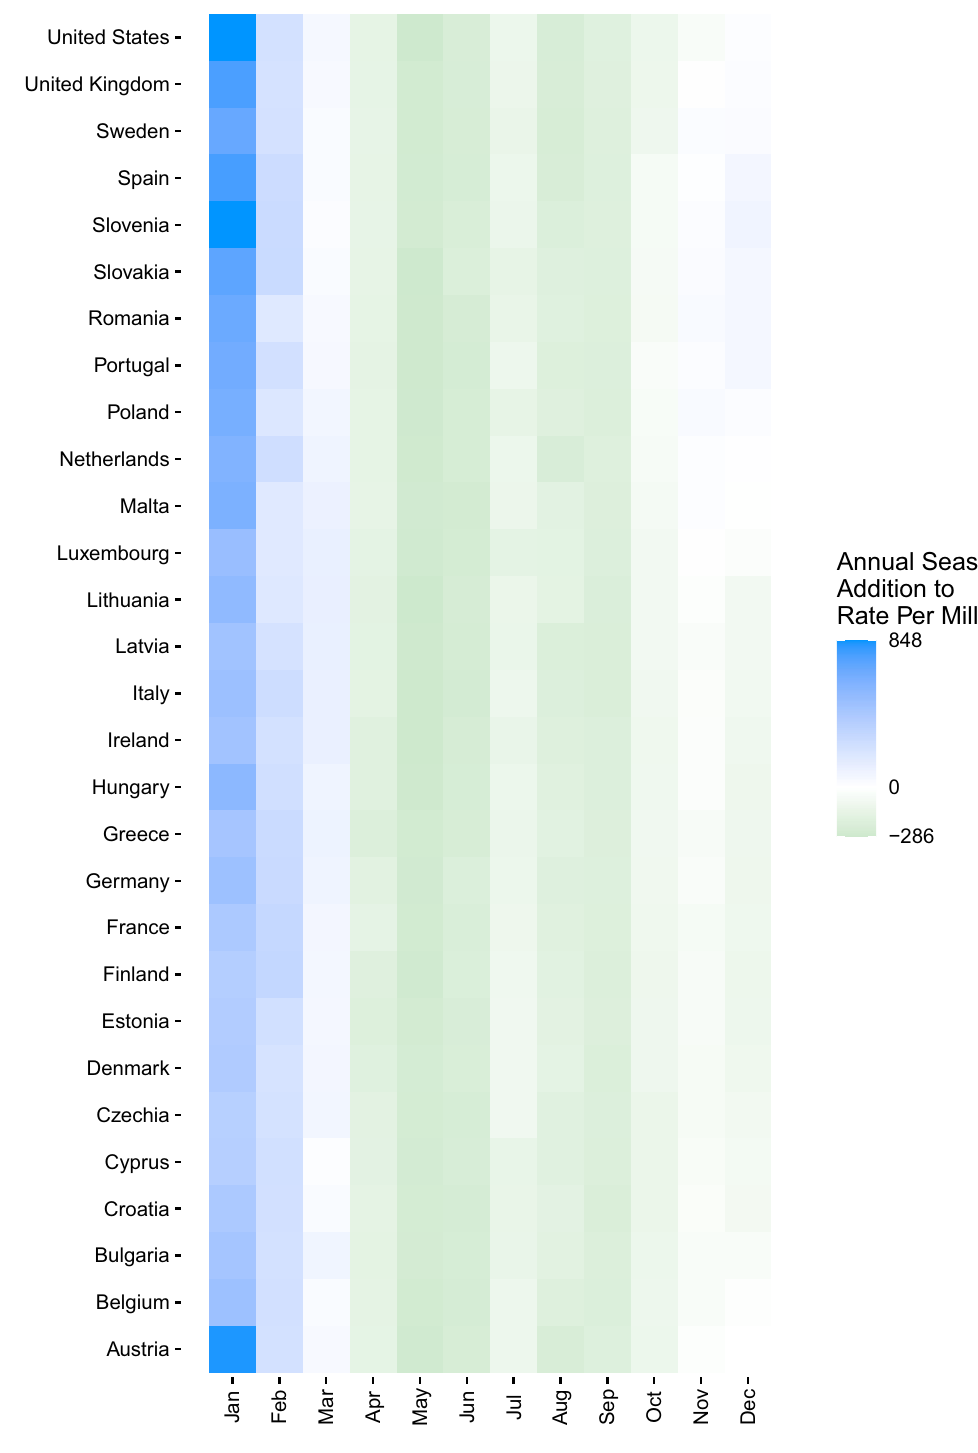
Figure 1. Heatmap of COVID-19 median annual seasonal components by month by country, 01 Mar 2020–31 Dec 2022. ( A ) Cases per million population; ( B ) COVID-19 hospitalizations per million population. ( C ) COVID-19 mortality per million population. Data Source: Our World in Data 19,20